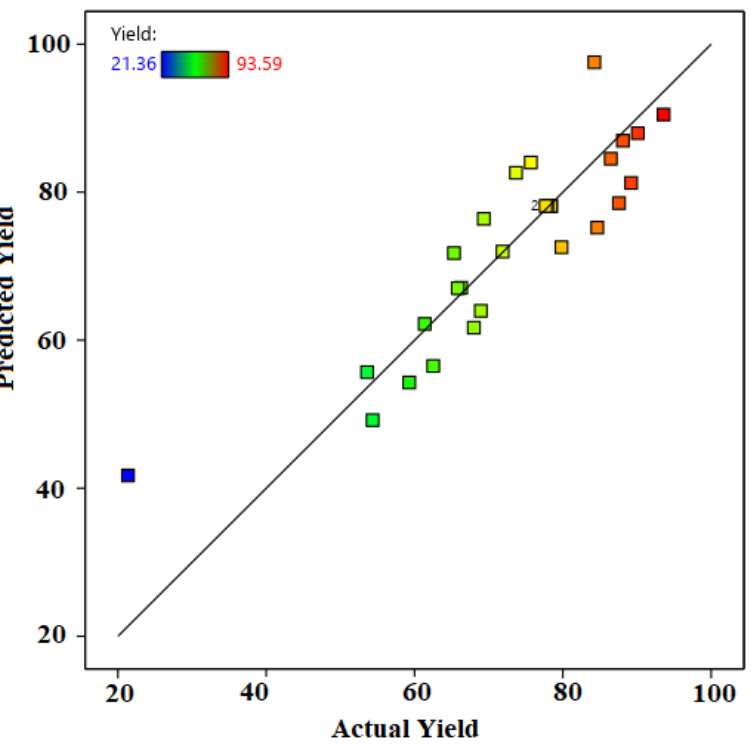
Figure 5. Correlation of the biodiesel yield obtained by the experiment (actual yield) and calculated results based on the model predicted by RSM (predicted